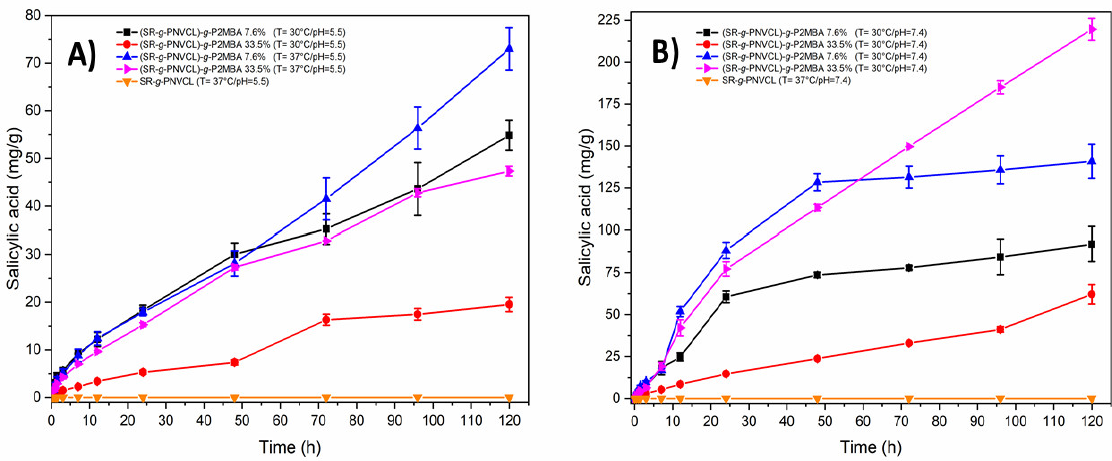
Figure 9. Salicylic acid release profile from (SR- g -PNVCL)- g -P2MBA films at ( A ) pH = 5.5 and ( B ) pH = 7.4.